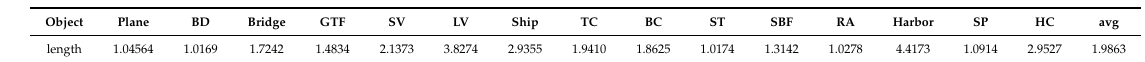
Table 9. Mean length of the